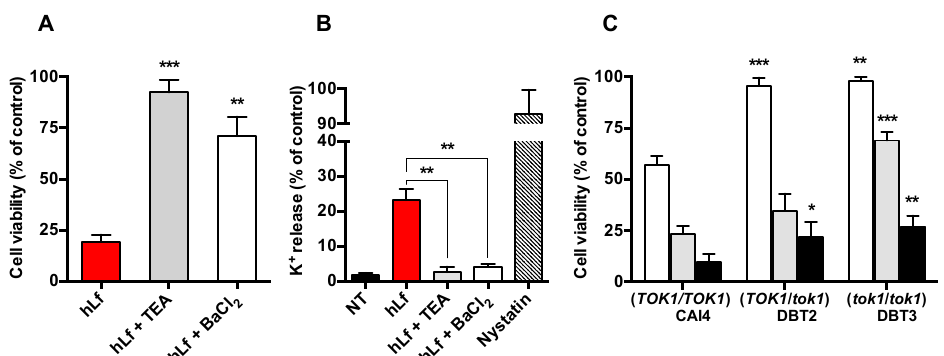
Figure 2. Identification of K + -channel involved in the lactoferrin-induced RCD process. ( A ) Viability of yeast cells (10 5 cells/mL) suspended in Tris buffer and treated with 5 μ M lactoferrin (hLf, red column) or pre-incubated for 15 min at 37 °C with the K + -channel inhibitors tetraethylammonium (10 mM TEA; gray column) or Ba 2+ (10 μ M BaCl 2 ; white column) before the addition of 5 μ M hLf. ( B ) Potassium efflux measured from non-treated cells (NT) assayed under the above conditions (black column; negative control), treated with hLf alone (red column) or pre-incubated with 10 mM TEA (gray column) or 10 μ M BaCl 2 (white column) before the addition of lactoferrin. Nystatin (100 μ g/mL) was used as a positive control of K + released by permeabilized cells (dashed column). ( C ) Antifungal activity of three concentrations of hLf on C. albicans TOK1 -disrupted strains. The strains (10 5 cells/mL) were incubated for 90 min at 37 °C with 1.25 μ M (white column), 2.5 μ M (gray column), or 5 μ M (black column) of lactoferrin. All the percentages of viability and K + released correspond to cells suspended in Tris buffer and incubated with hLf for 90 min at 37 °C. The cell viability was determined by a plate-count method. The results are the means ± SD from duplicates of at least three independent experiments. Statistical significance was assessed by Student’s t test. * p < 0.05; ** p < 0.01; *** p < 0.001.